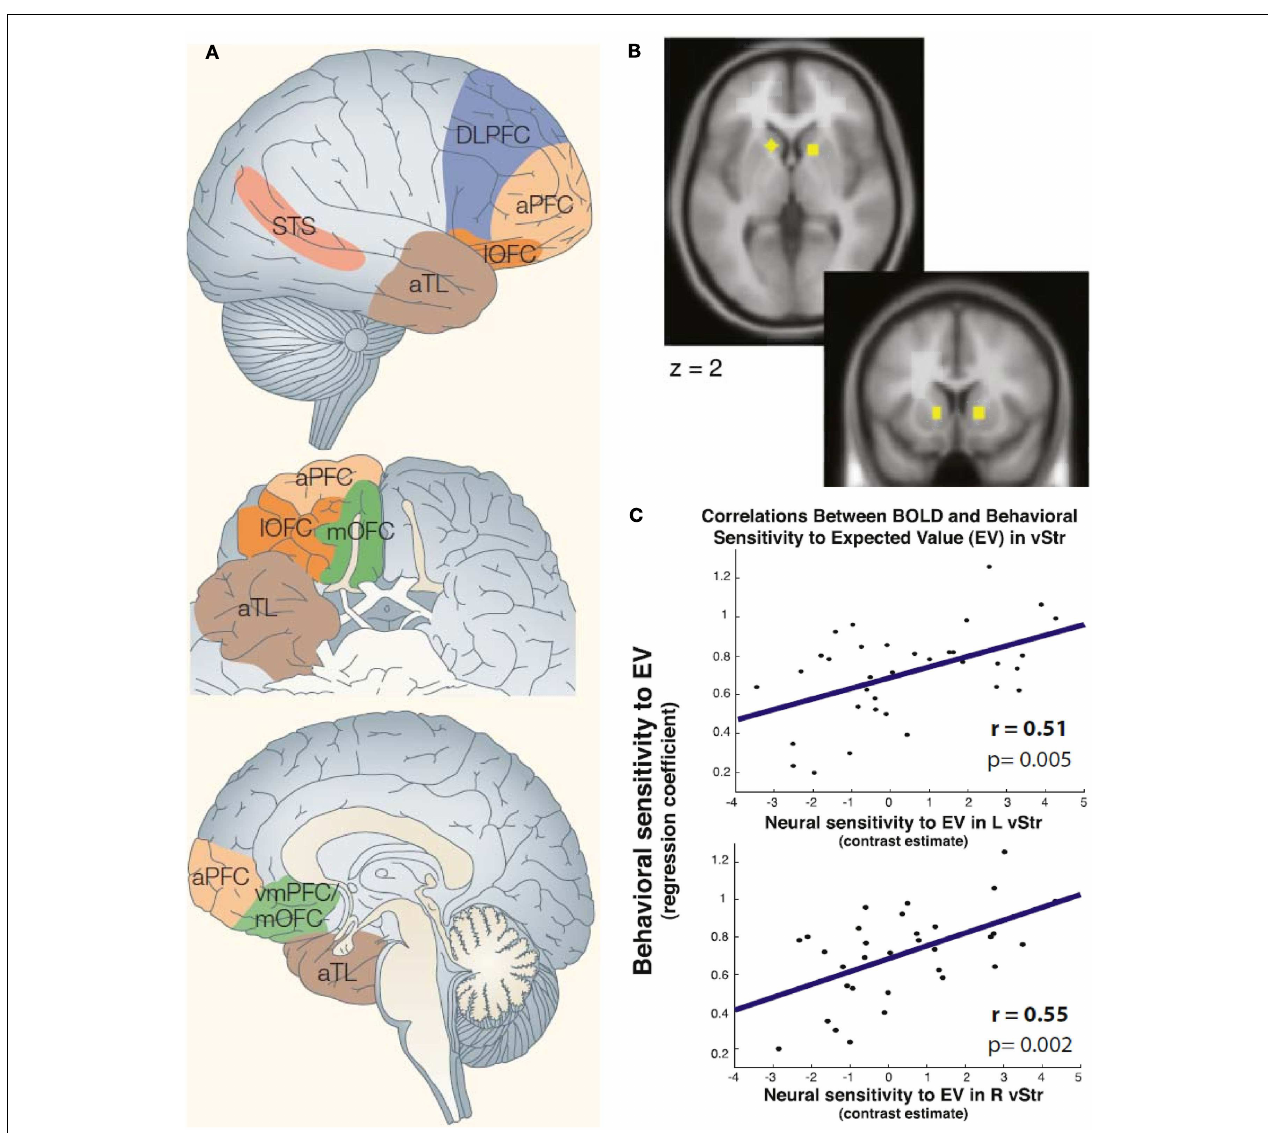
probability rather than a single individual with certainty. Across trials, group size, and probability varied. Group size and probability should be multiplied to compute the expected number of lives saved. (B) Regions in ventral striatum previously identified by Knutson et al. (2005) as processing reward value. (C) In the regions shown in (B) , individual neural sensitivity (contrast estimates of activation increases) correlated with behavioral sensitivity (beta estimates